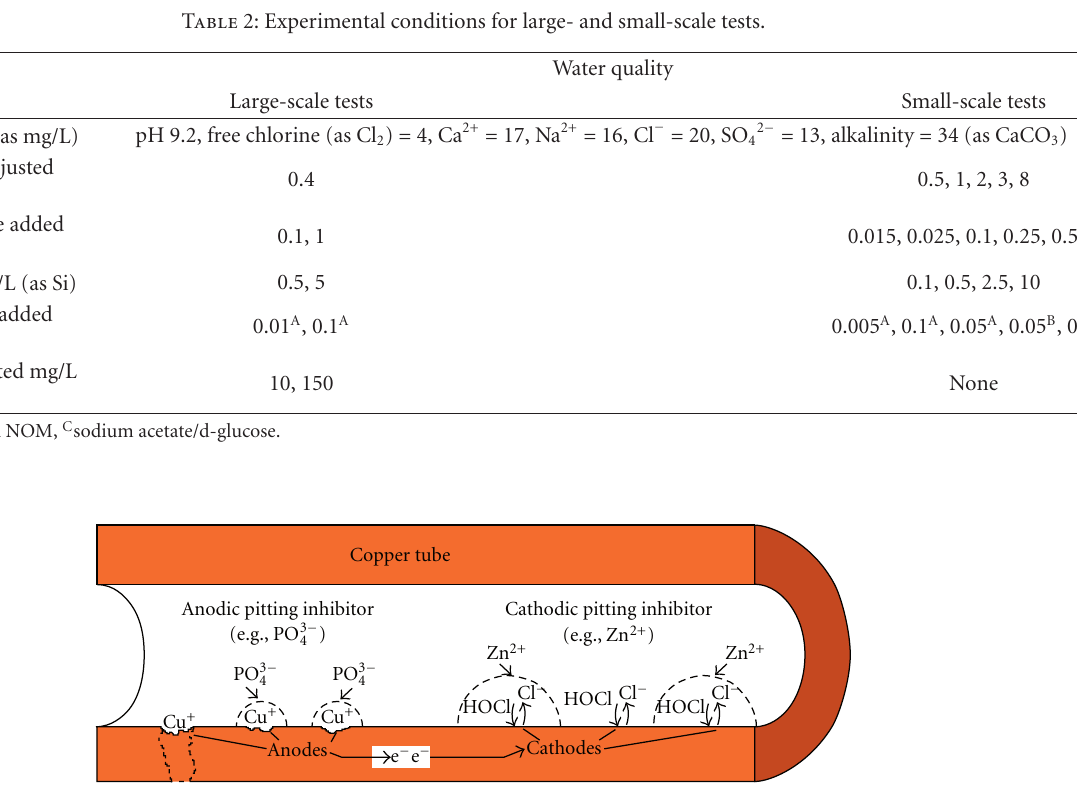
Figure 1: Simplified depiction of conventional wisdom regarding pit inhibition by anodic and cathodic